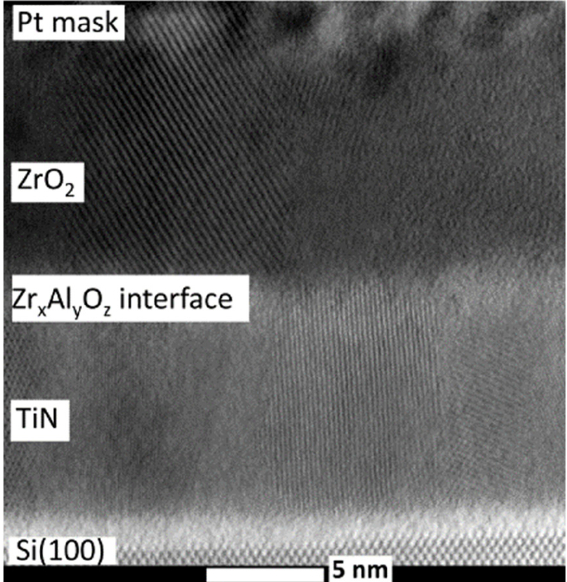
Figure 7. BF STEM image of Zr x Al y O z -ZrO 2 film deposited using the cycle sequence of 5 × (ZrCl 4 + Al(CH 3 ) 3 + H 2 O) + 80 × ZrO 2 . Substrate, bottom electrode and component layers are denoted by labels.